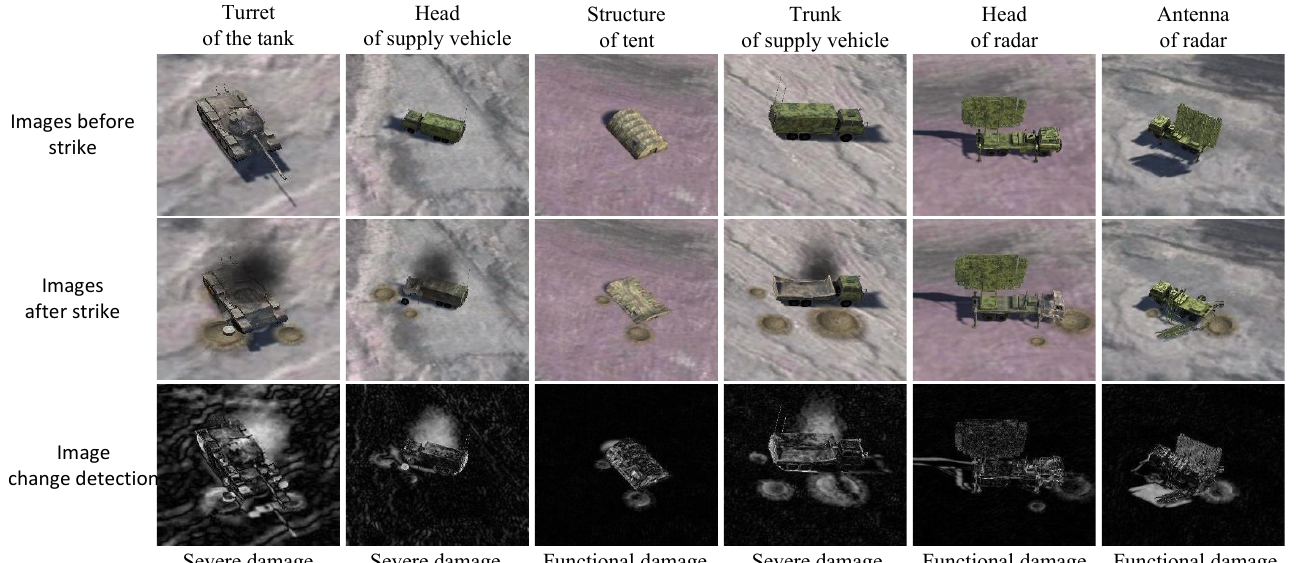
Figure 16. The result of PCA-k-means assessment.